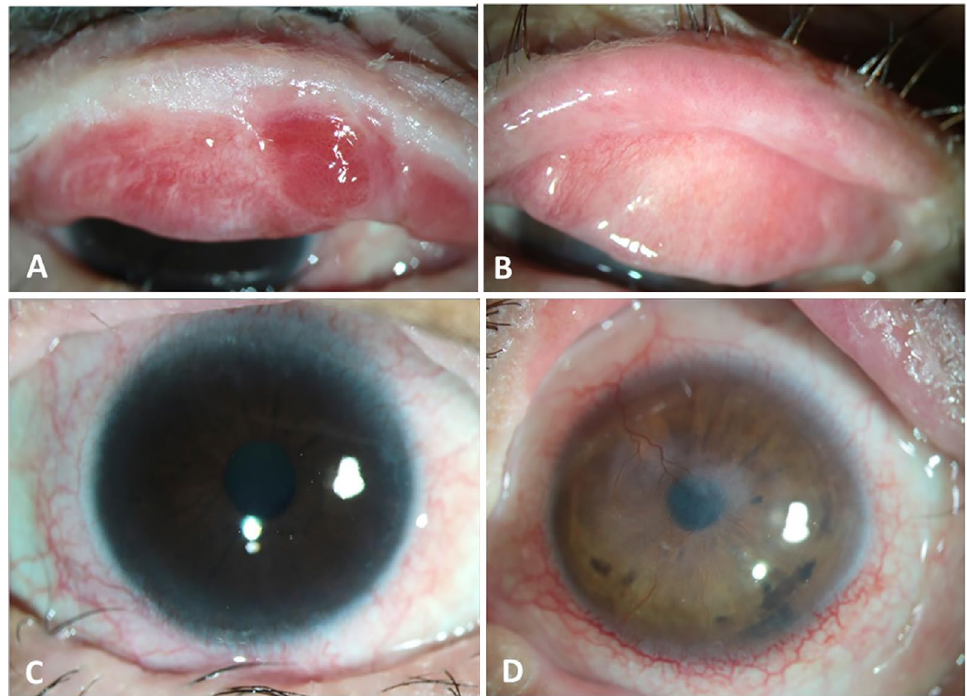
Figure 1. Ocular characteristics in eyes with chronic Stevens–Johnson syndrome. ( A ) Lid margin keratinization with tarsal conjunctival scarring in the upper eyelid (patient 11); ( B ) Upper lid post lid margin mucous membrane graft (patient 9); ( C ) peripheral corneal vascularization (patient 11); ( D ) Corneal scarring with vascularization with peripheral limbal vascularization (patient